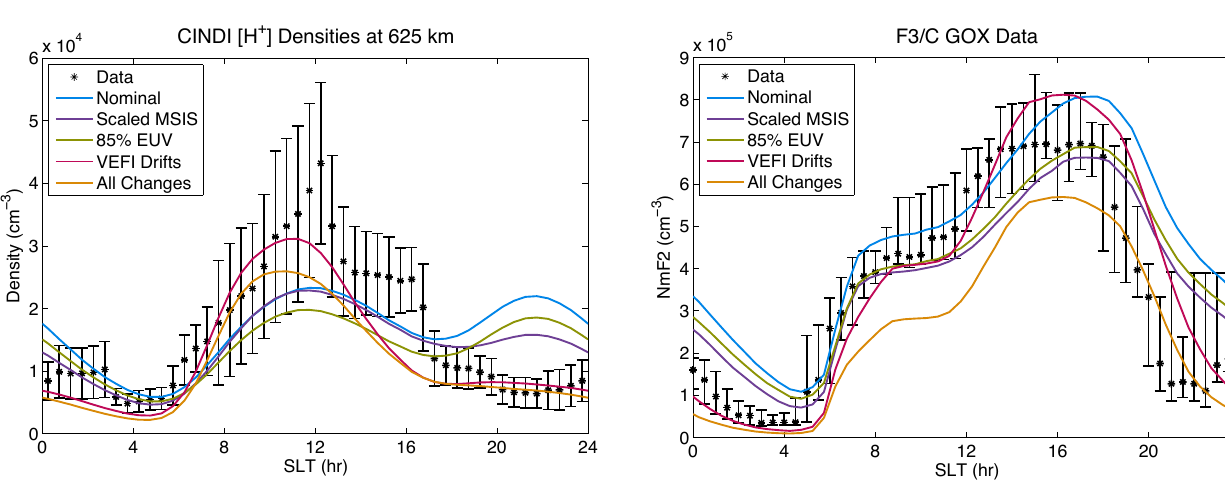
N F Fig. 7. The median m 2 values derived from F3/C, with the vertical bars representing the upper and lower quartiles. The modeled results are the same as Figure 4.